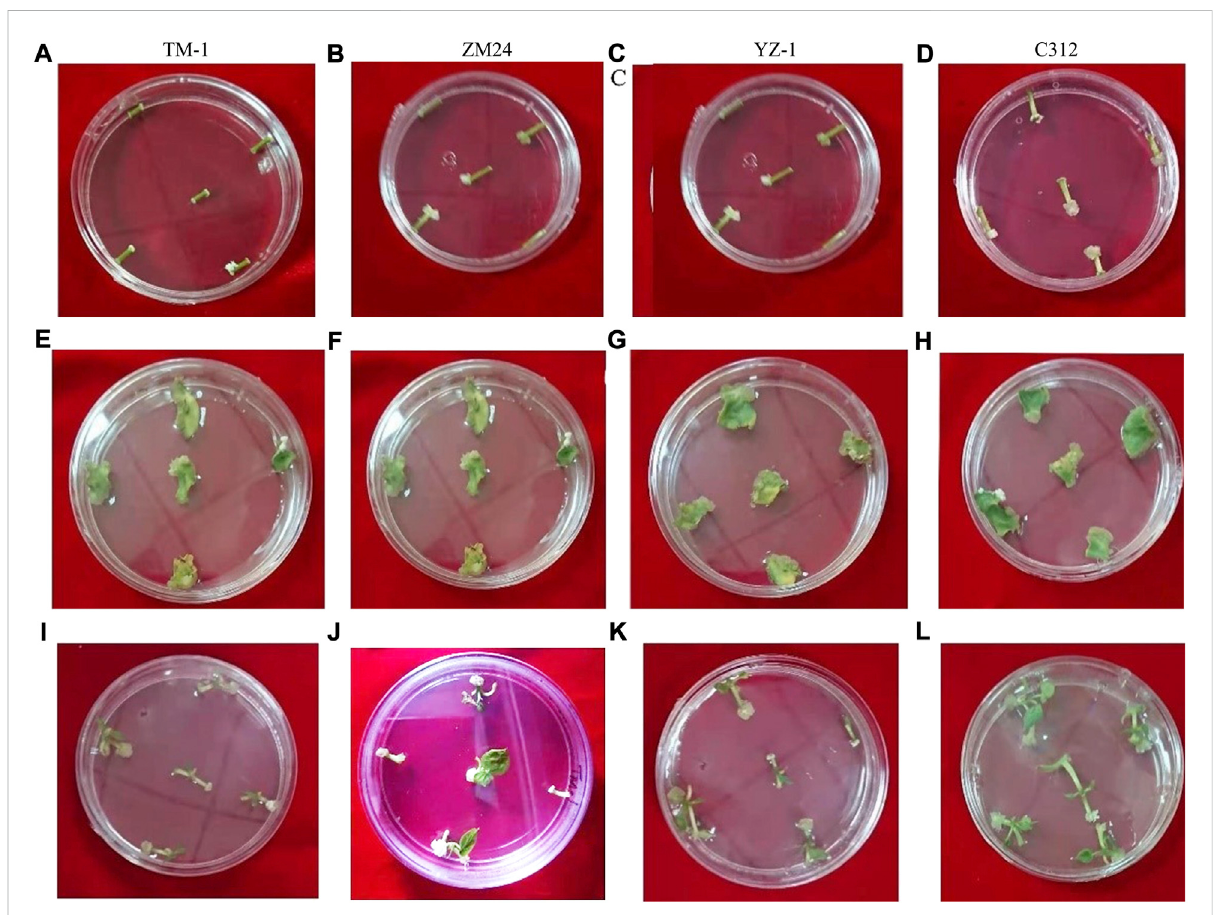
FIGURE 4 Callus induction rate in G. hirsutum . (A) 1-day hypocotyl callus induction for TM-1, (B) 2-day hypocotyl callus induction for ZM24, (C) 2.5-day hypocotyl callus induction for YZ-1, (D) 3-day hypocotyl callus induction for C312, (E) 1-day cotyledon callus induction for TM-1, (F) 2-days ’ cotyledons callus induction for ZM24, (G) 2.5-day cotyledon callus induction for YZ-1, (H) 3-day cotyledon callus induction for C312, (I) 1-day shoot tipcallusinductionforTM-1, (J) 2-dayshoottipcallusinductionforZM24, (K) 2.5-dayshoottipcallusinductionforYZ-1,and (L) 3-dayshoottip callus induction for